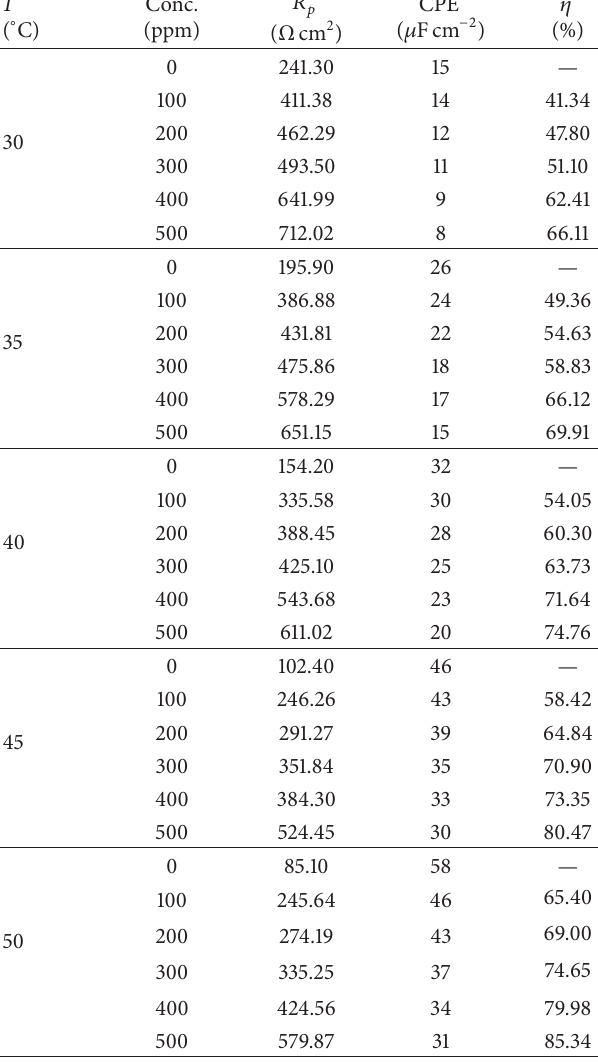
Table 2: Electrochemical impedance values of aluminum in 0.5M phosphoric acid solution containing different concentrations of inhibitor (GIE) at different